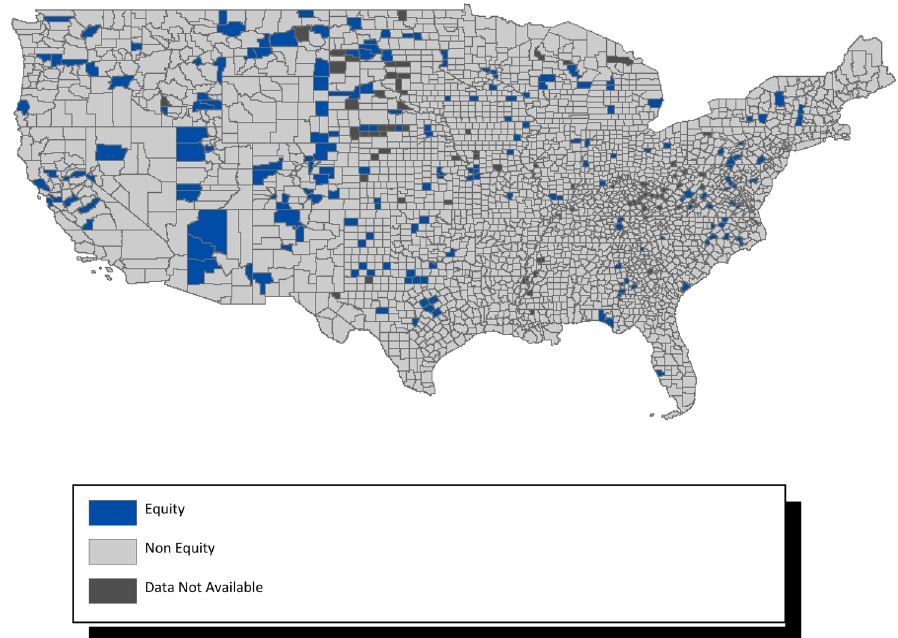
Figure 4. County level racial equity in optimal births—white to hispanic. Map generated in ArcMap 10.7 (https:// www. esri.